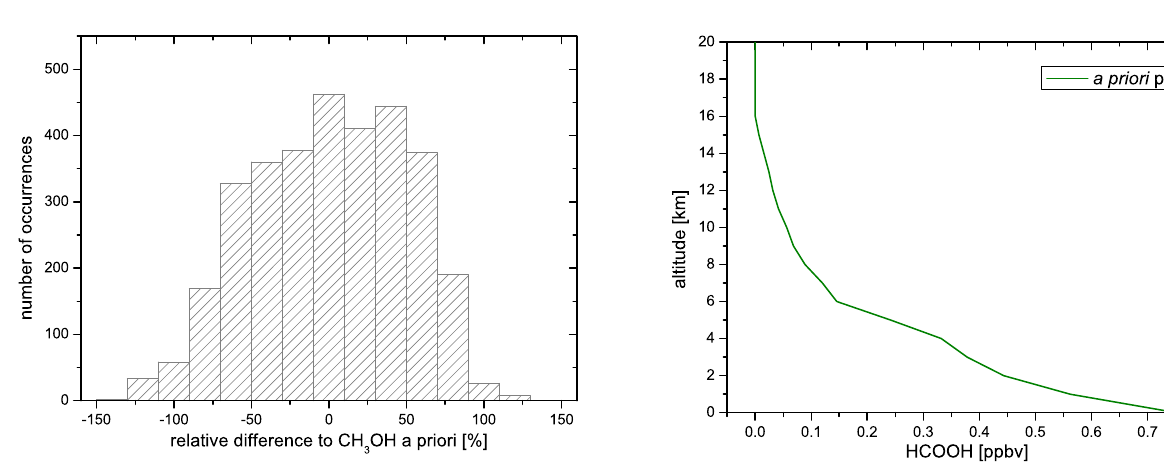
Fig. 7. Histogram of the relative differences between the simulated CH 3 OH total columns and the total columns derived from the 1T b calculation.